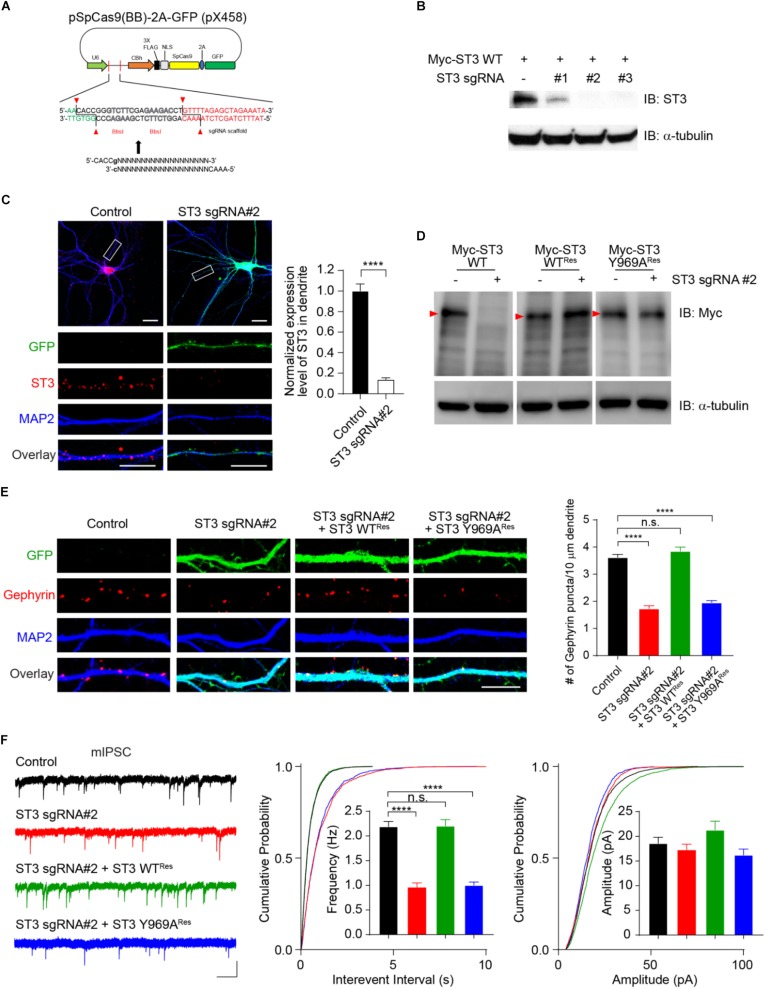
Single-cell genetic deletion and rescue of ST3 reveal the importance of Y969 in the regulation of GABAergic transmission. (A) Schematic diagram of CRISPR/Cas9 vector (simultaneously expresses GFP) targeting ST3 gene loci in mouse genome. (B) Screening of knockout effect of candidate sgRNAs in HEK293T cells. Western blot analysis showed that sgRNA#2 and sgRNA#3, but not sgRNA#1, strongly reduced ST3 expression in HEK293T cells. α-tubulin was used as an internal control. N = 3 independent repeats. (C) Confocal images and quantification analysis showed a significant decrease of ST3 expression in the dendritic region of hippocampal neurons expressing sgRNA#2 (Control, 1.0 ± 0.07, n = 12; ST3 sgRNA#2, 0.14 ± 0.02, n = 12, unpaired t-test, ∗∗∗∗p < 0.0001. N = 3 independent repeats). Scale bar, 20 mm (top) and 10 mm (bottom). (D) Western blot analysis validated the expression of sgRNA#2 resistant WT ST3 (ST3 WTRes) and the Y969A mutant (ST3 Y969ARes) in HEK293T cells. α-tubulin was used as an internal control. Red arrow heads indicated Myc-ST3 protein bands. N = 3 independent repeats. (E) Representative images and quantification analysis showed that the decrease of gephyrin puncta density in hippocampal neurons expressing ST3 sgRNA#2 could be rescued by co-expressing ST3 WTRes, but not ST3 Y969ARes (Control, 3.62 ± 0.11, n = 15; ST3 sgRNA#2, 1.73 ± 0.10, n = 13; ST3 sgRNA#2 + ST3 WTRes, 3.85 ± 0.14, n = 13; ST3 sgRNA#2 + ST3 Y969ARes, 1.96 ± 0.07, n = 14. One-way ANOVA test, ∗∗∗∗p < 0.0001. N = 3 independent repeats). Scale bar, 10 mm. (F) mIPSC recording data showed that sgRNA#2 resistant WT ST3, but not ST3 Y969A, could fully rescue GABAergic transmission deficits in hippocampal cultured neurons expressing sgRNA#2. Insets displayed the mean ± SEM frequency and amplitude, respectively [Frequency (Hz): Control, 2.19 ± 0.11, n = 12; ST3 sgRNA#2, 0.96 ± 0.09, n = 10; ST3 sgRNA#2 + ST3 WTRes, 2.2 ± 0.13, n = 10; ST3 sgRNA#2 + ST3 Y969ARes, 1.0 ± 0.06, n = 10. One-way ANOVA test, ∗∗∗∗p < 0.0001. K–S test, p < 0.0001 between Control and ST3 sgRNA#2 or ST3 sgRNA#2 + ST3 Y969ARes for interevent interval. Amplitude (pA): Control, 18.59 ± 1.23, n = 12; ST3 sgRNA#2, 17.25 ± 1.18, n = 10; ST3 sgRNA#2 + ST3 WTRes, 21.31 ± 1.79, n = 10; ST3 sgRNA#2 + ST3 Y969ARes, 16.21 ± 1.21, n = 10. One-way ANOVA test, p > 0.05. K–S test, p < 0.0001 between Control and ST3 sgRNA#2 + ST3 WTRes for amplitude, p < 0.001 between Control and ST3 sgRNA#2 + ST3 Y969ARes for amplitude. N = 3 independent repeats]. Scale bar, 20 pA and 1 s.